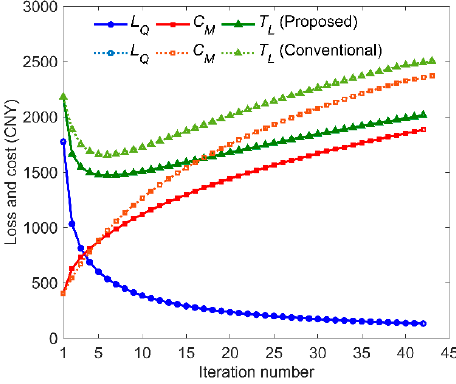
Figure 7. Results of tolerance optimization process.